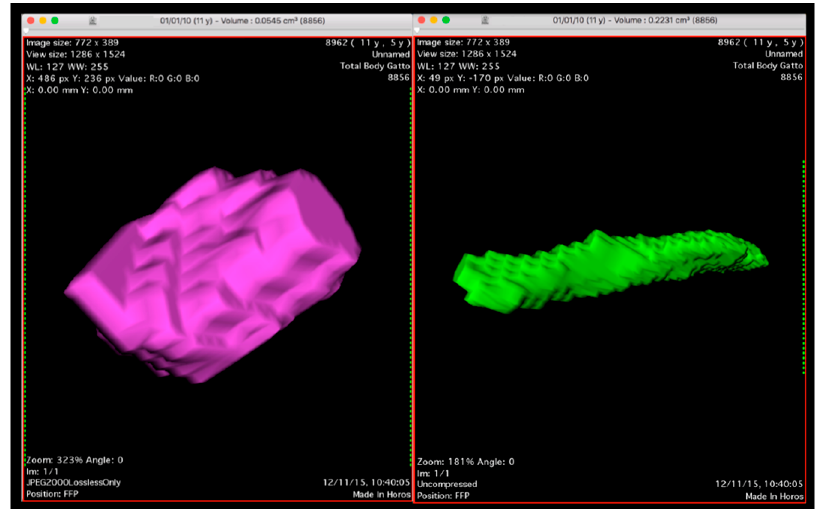
Figure 1. 3D Volume Rendering sample of an elongated jejunal ( right ) and rounded gastric lymph node ( left ) calculated by software according to the procedure described.